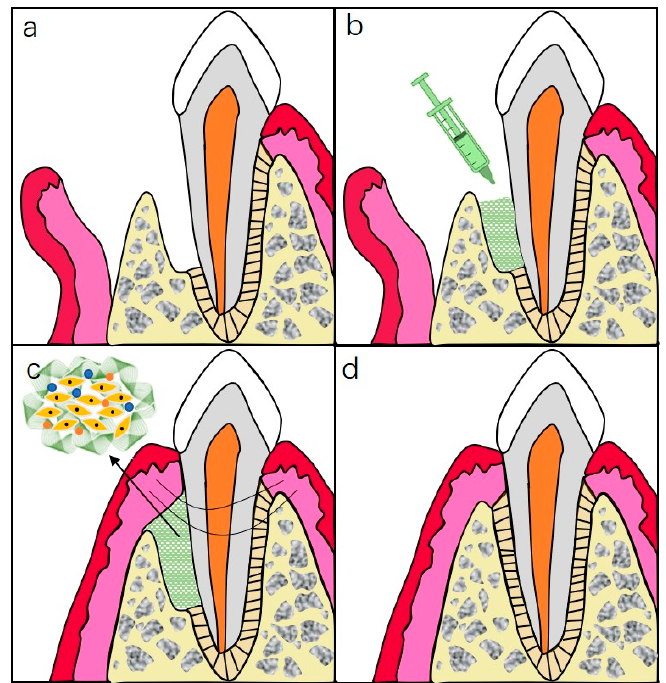
Figure 5. Schematic illustration of injectable hydrogels for periodontal repair. ( a ) Periodontal defect with loss of PDL and alveolar bone. ( b ) Inject hydrogel complexes into the defected site. ( c ) Sewing for closure of the wound. ( d ) Ideal repairment of periodontal tissue.